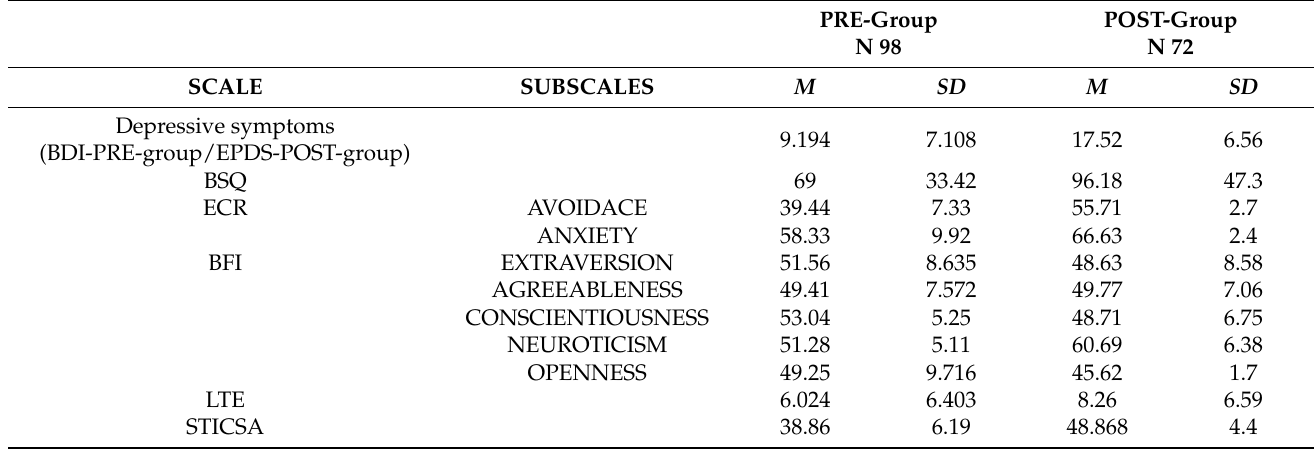
Table 2. Mean values and standard deviations of the key variables and groups.